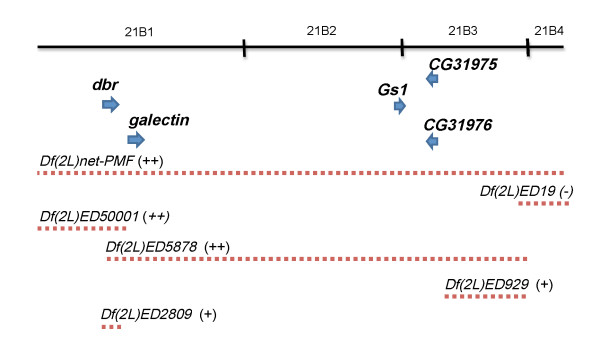
Molecular characterization of the PD-interacting cytological region 21A1-21B7. Genes (arrows) are listed according to their genomic location. The regions uncovered by the deficiencies used in the experiments are indicated (dashed lines). The effect of each deficiency is indicated as enhancement (+) or no enhancement (-).